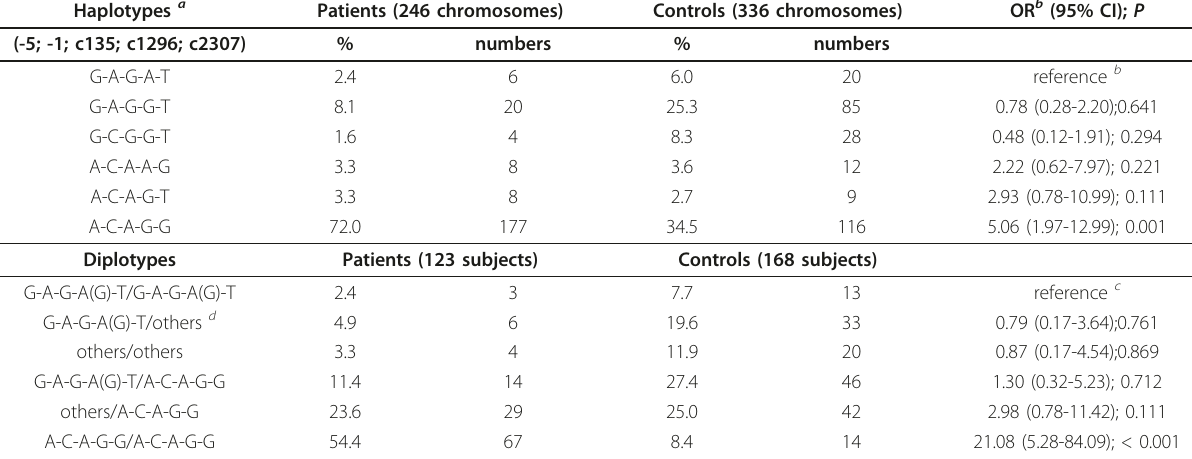
Table 2 Frequencies and counts of RET haplotypes and diplotypes comprising -5G > A, -1A > C, c135G > A, c1296A > G and c2307T > G Haplotypes